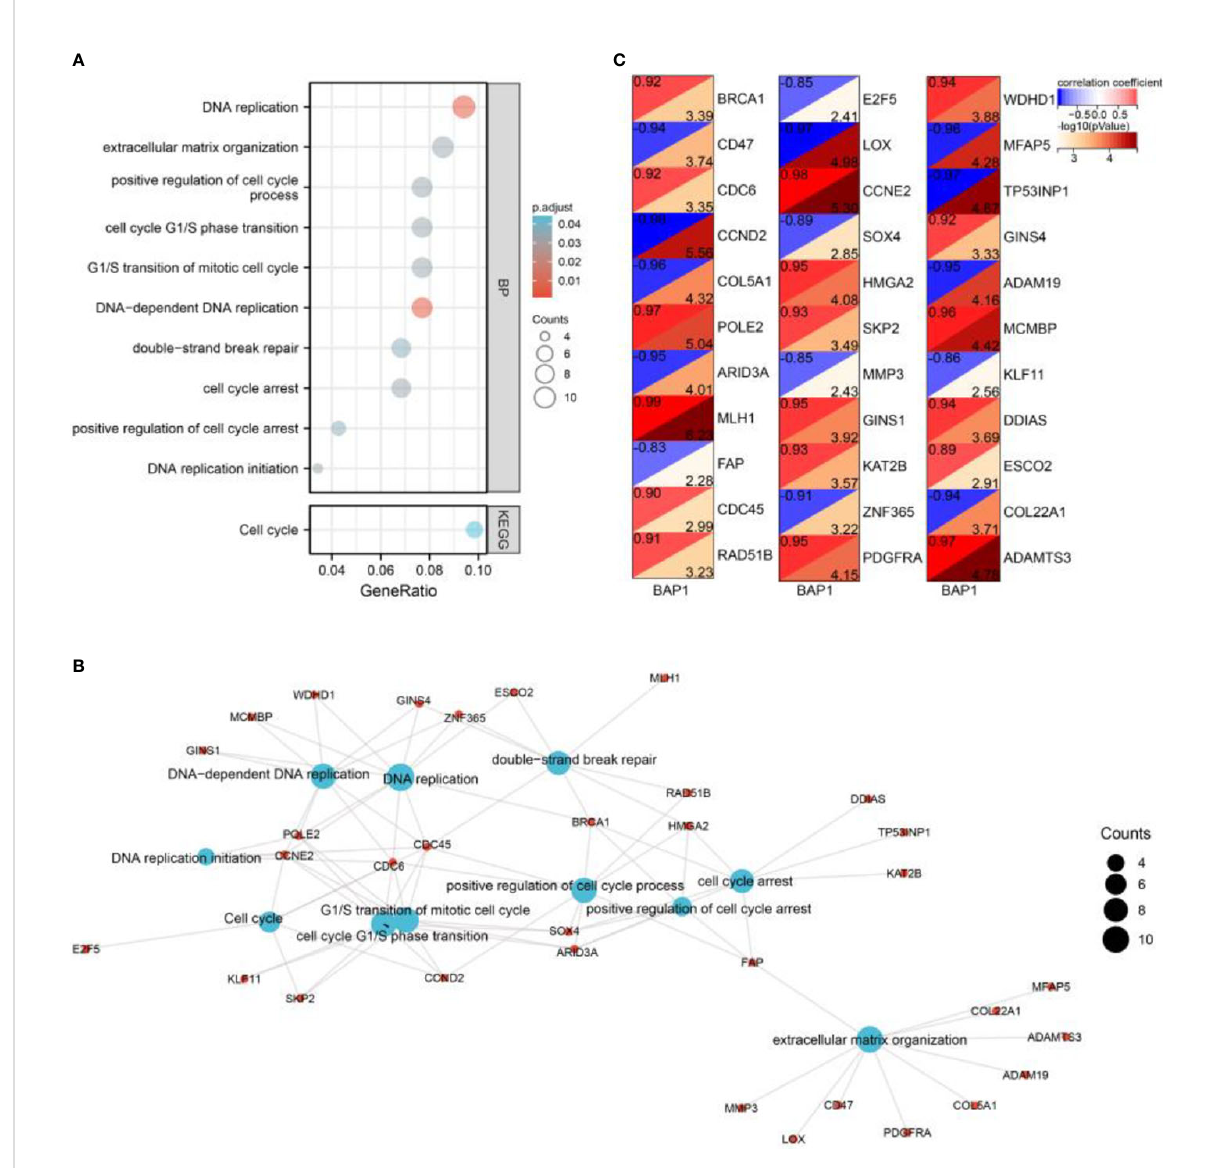
FIGURE 3 Enrichment analysis of DEGs. (A) GO and KEGG analysis of DEGs. (B) A network of enriched terms and DEGs. (C) Pearson analysis of BAP1 and DEGs enriched in GO and KEGG